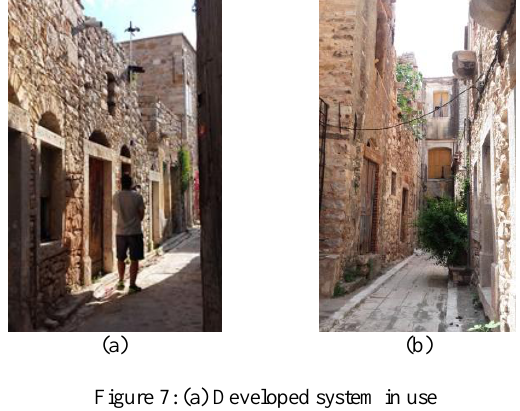
Figure 7: (a) Developed system in use (b) Obstacles during image acquisition